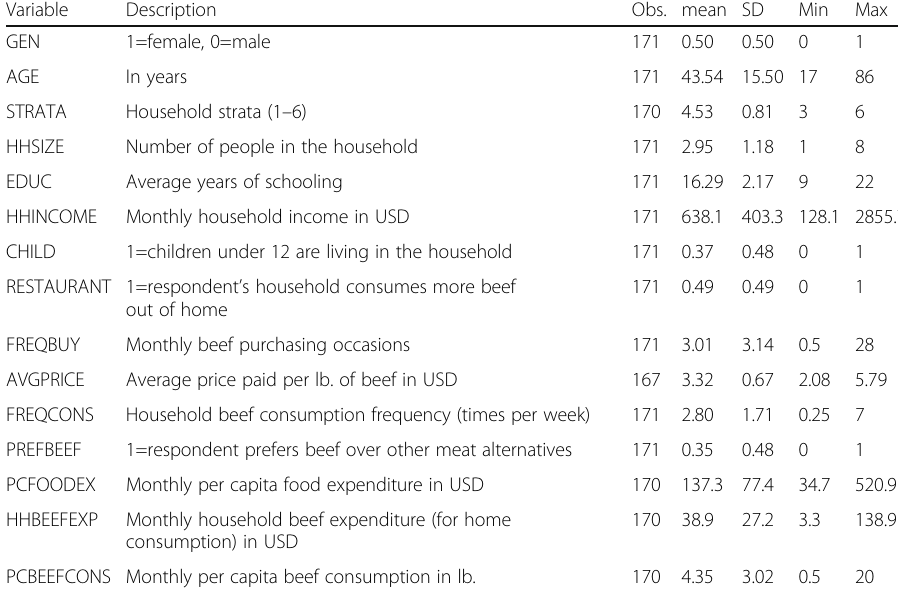
Table 4 Stage 2 — DCE summary